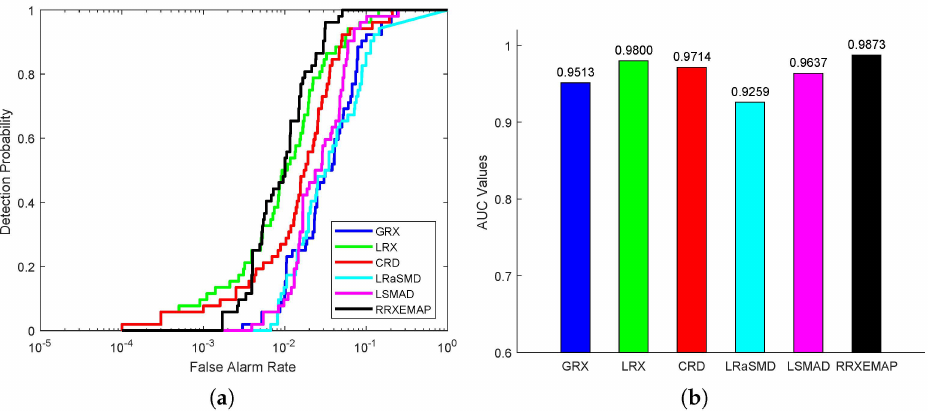
Figure 17. Detection accuracy evaluation for the abu-urban-3 dataset. ( a ) ROC curves. ( b ) AUC values.